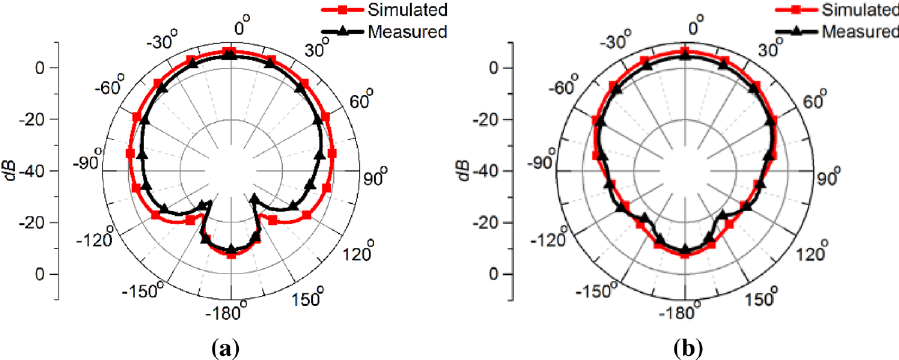
Figure 17. Simulated and measured realized gain patterns of the open-ended quartz loaded waveguide operating at 2.45 GHz in air ( a ) E-plane, ( b )